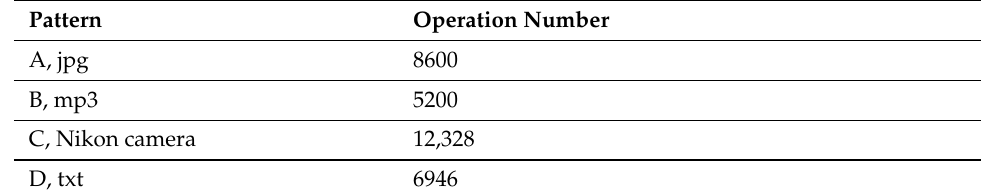
Table 3. Traces for the